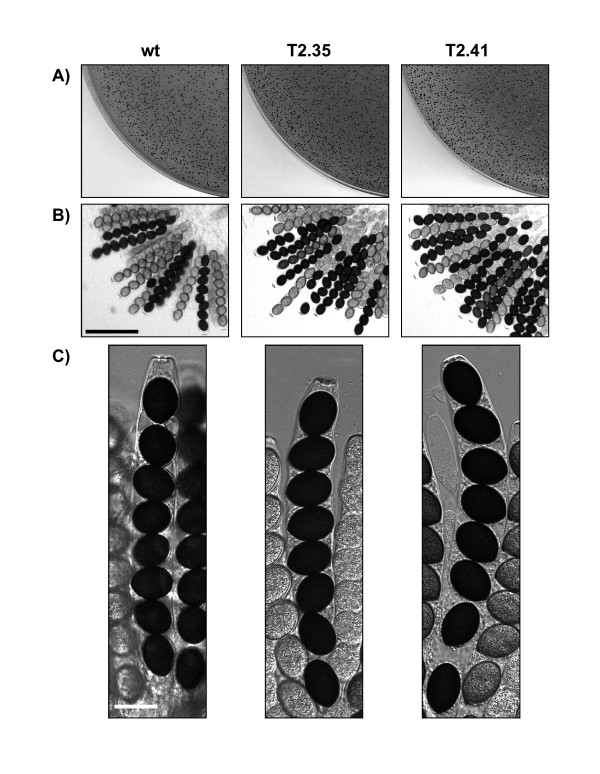
Δtap1 strains have a wild type-like phenotype. The wild type and Δtap1 single spore isolates T2.35 and T2.41 (as indicated above each column) were grown in Petri dishes on BMM solid medium [10, 21] for 6d (A) or 7d (B, C) at 25°C in constant light. A) Segments of petri dishes, black dots are individual fruiting bodies. B) Segments of ascus rosettes with mature (black-spored) and immature asci. Scale bar 100 μm. C) Mature asci. Scale bar 20 μm.